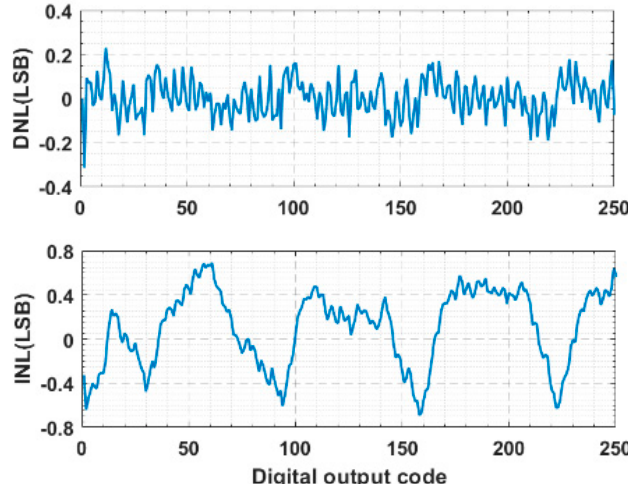
Figure 13. Measured differential nonlinearity (DNL) and integral nonlinearity (INL).